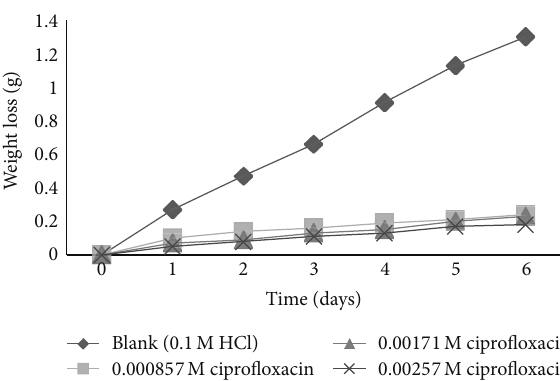
Figure 2: Variation of weight loss with time of exposure for corrosion mild steel in 0.1 M HCl solution in absence and presence of different concentrations of